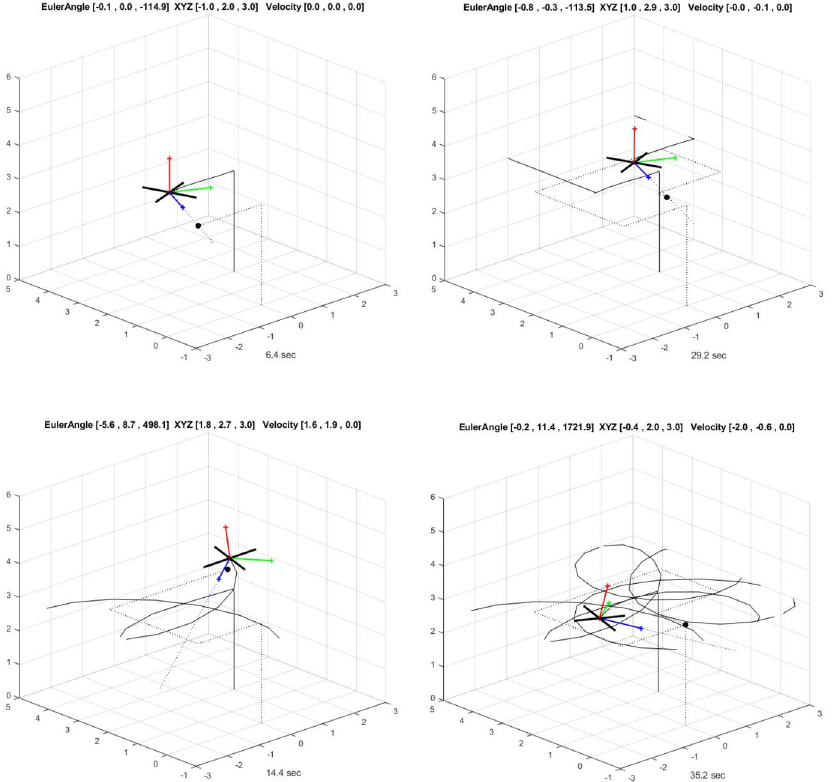
Fig 6. ( a ) Drone controlled followed square motion; ( b ) Drone controlled followed near radar on square motion; (c) Drone losing control as it received signal power of over 2.5 MHZ; (d) A drone that completely loses control after receiving a significant jamming